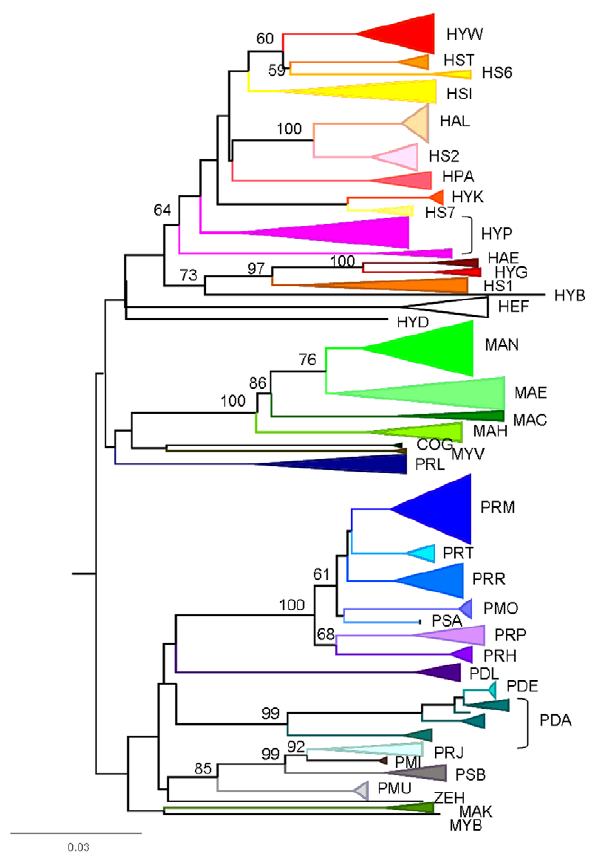
algorithm constructs a family of trees from the training set by randomly choosing subsets of m polymorphic sites and running